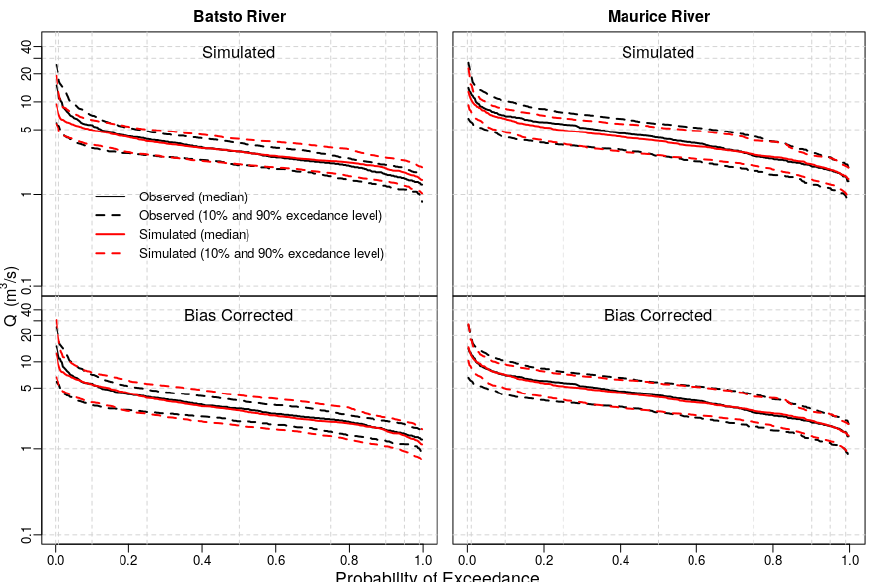
Figure 6. Median, 10%, and 90% exceedance levels for annual flow duration curves for simulations in each basin. The upper two plots show the calibrated PRMS simulations for uncorrected stream flows compared to observed flows. The second row of plots shows results from bias-corrected simulations compared to observed flows.